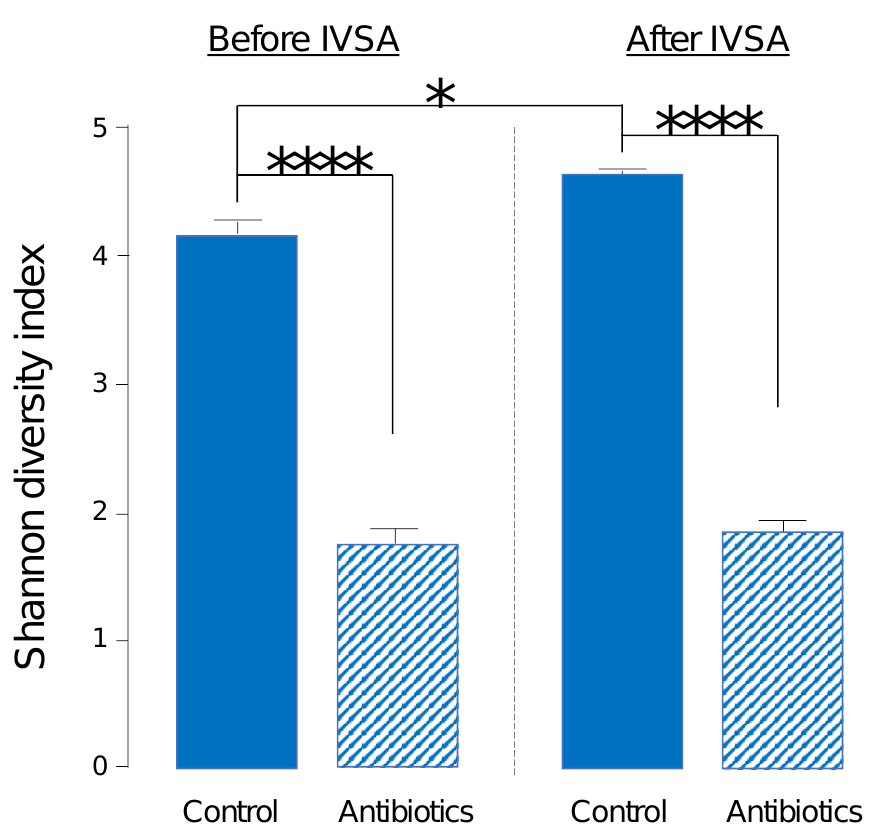
Figure 1. Shannon diversity index values from fecal samples before (left of dashed line) and after (right of dashed line) fentanyl intravenous self-administration (IVSA) in males treated with water only (solid bars) or water with antibiotics (dashed bars). Error bars represent S.E.M. **** p < 0.0001, * p < 0.05, n = 4 – 8/group.